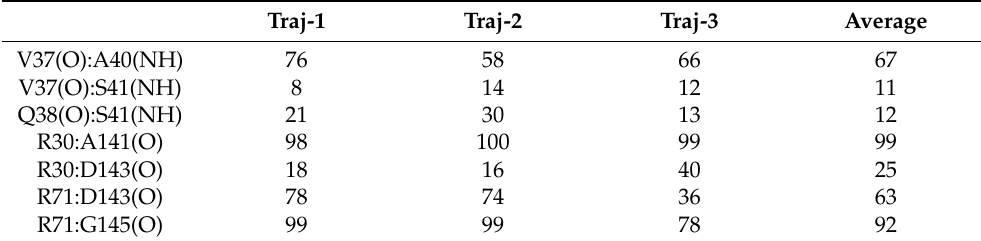
Table 1. Occupancies (in percentage) of crucial interactions associated with the initial progression directions of the matrix loops.